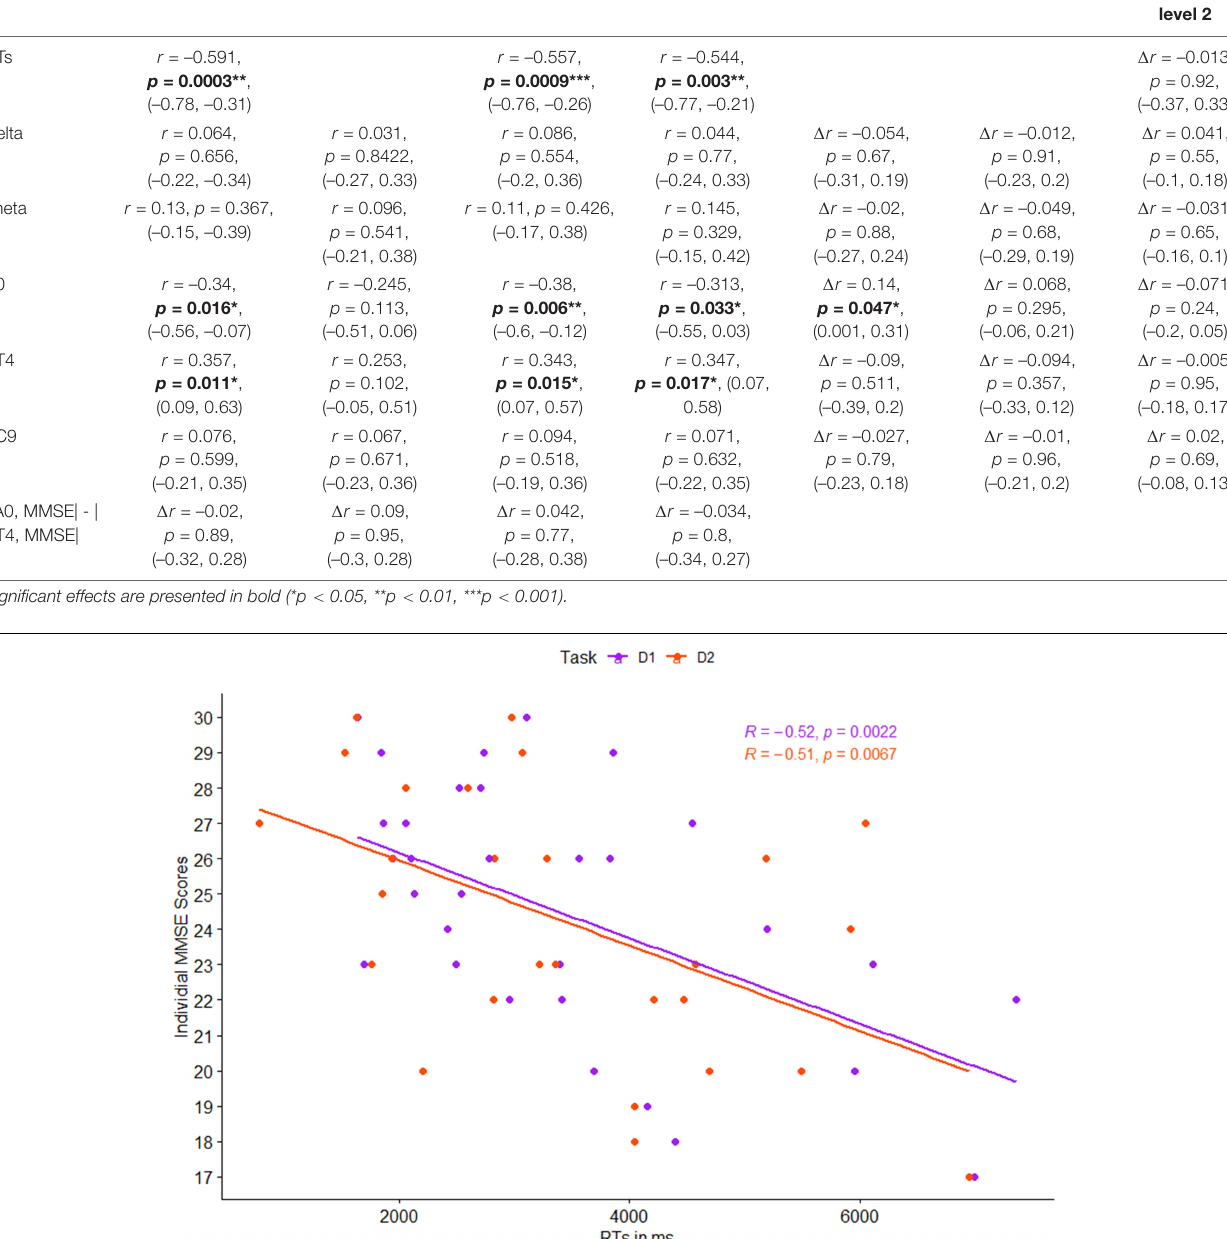
same tasks. Due to the relatively small sample size, we